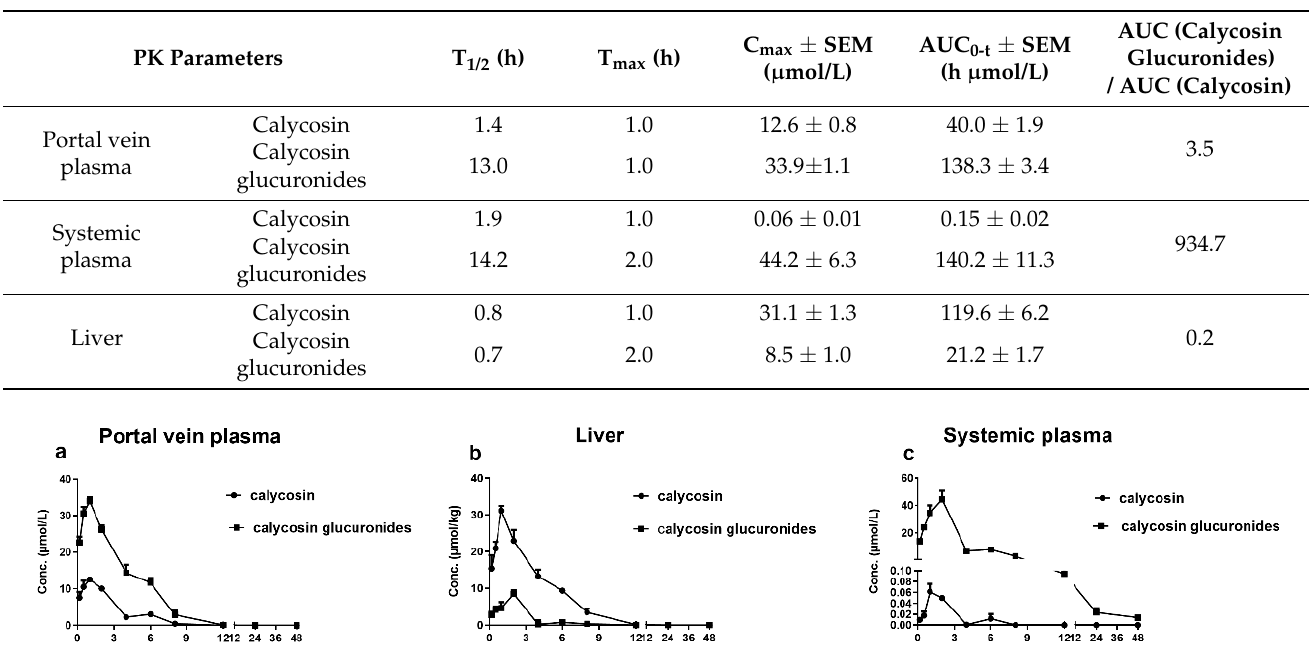
Table 2. PK parameters of calycosin and calycosin glucuronides in the portal vein plasma, systemic plasma, and liver after oral administration of calycosin at 76.4 mg/kg in rats (n = 5).